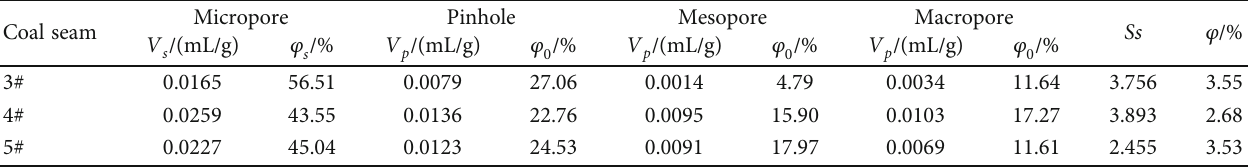
Table 2: Pore distribution characteristics.